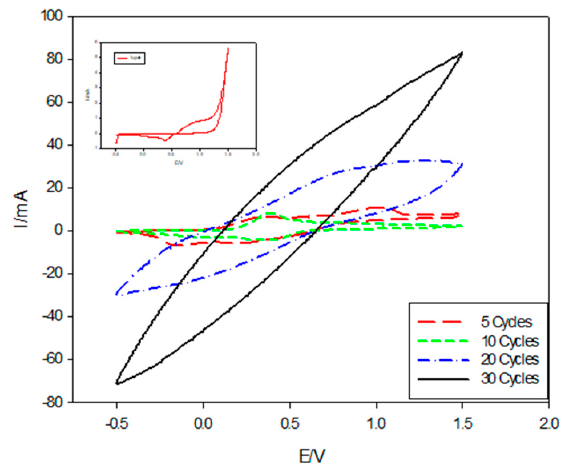
Figure 6. Cyclic voltammograms of PANI deposition on ITO in the presence of (0.5 M H 2 SO 4 , 0.1 M aniline) at different cycle numbers.